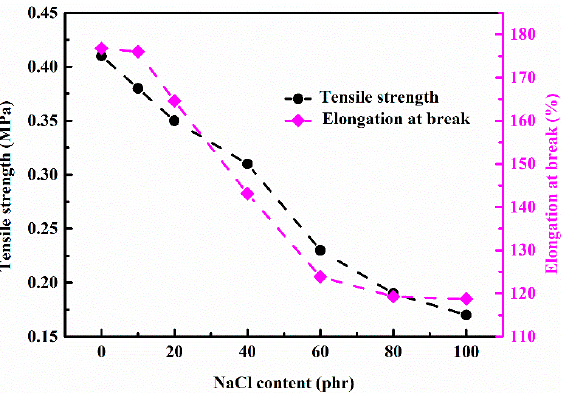
Figure 4. Effect of the addition amount of NaCl on the tensile strength and elongation at the break of silicon rubber forms. silicon rubber